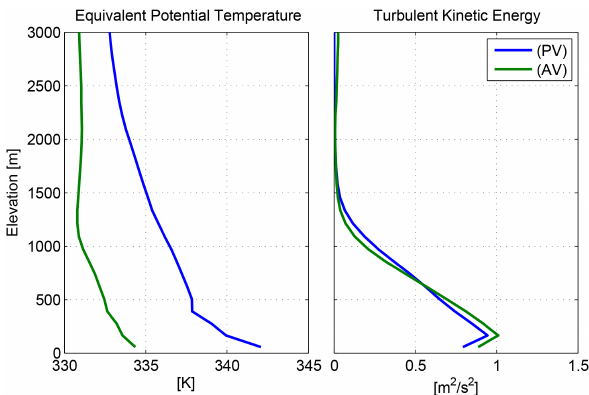
Figure 15. Mean profiles of equivalent potential temperature and turbulent kinetic energy at 15Z within the bounded domain at Gran Chaco, April